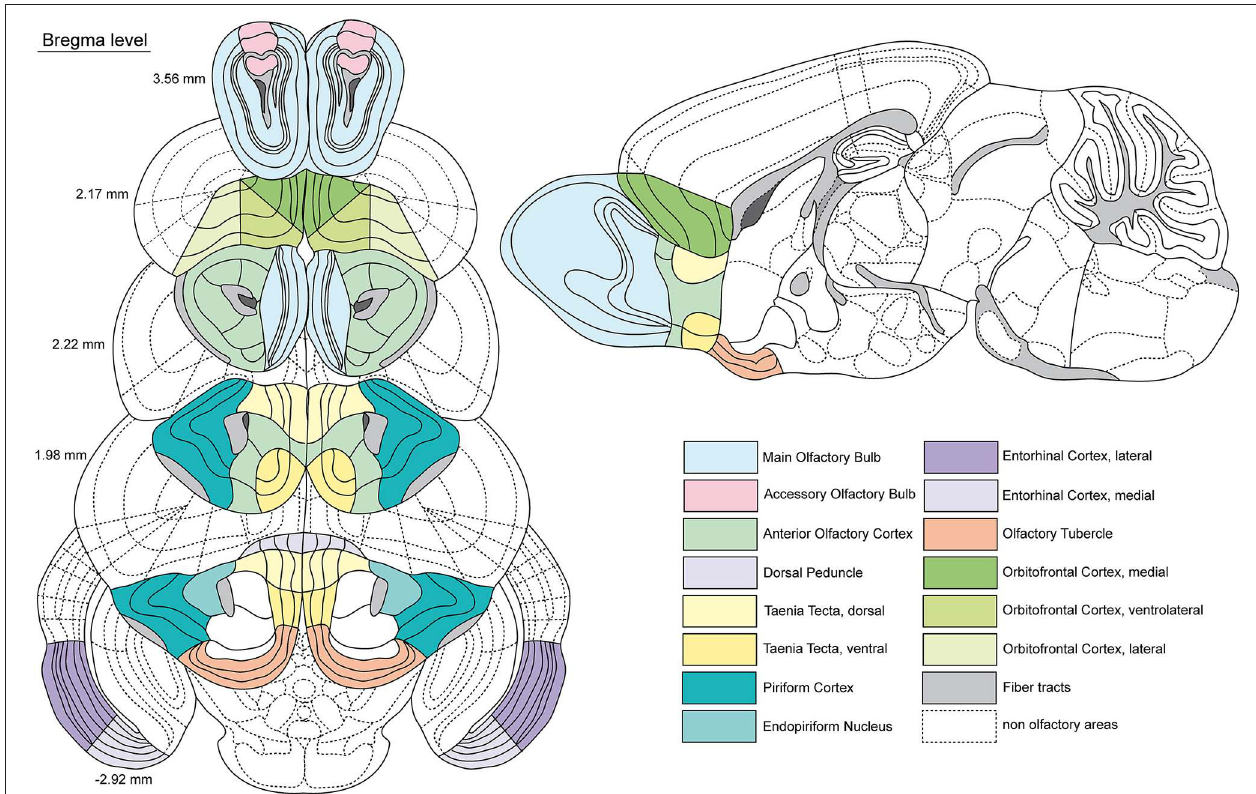
FIGURE 2 | Schematic representation of the investigated olfactory areas. Coronal sections of the mouse (C57BL/6) brain along the anterior-posterior axis (related Bregma levels alongside). A sagittal section serves for further local orientation of certain areas. The investigated areas are indicated by different colors (see legend). Dashed lines show non olfactory areas for a better orientation. Gray areas show fiber tracts, whereas dark gray areas represent the subventricular zone. Boundaries adapted by the Allen Brain Reference Atlas ( Lein et al., 2007; Dong,